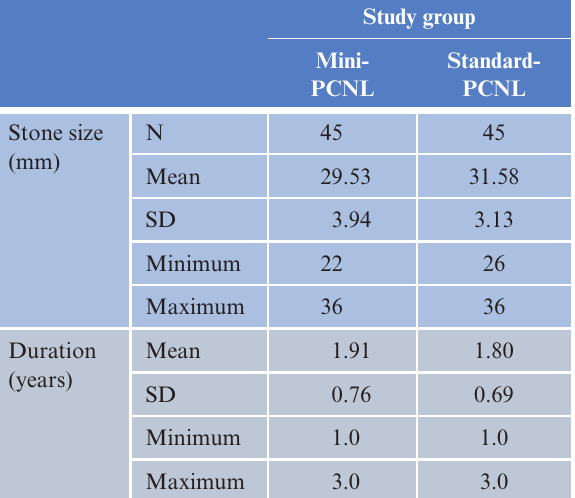
Table 1: Descriptive statistics of stone size and duration of renal stone.